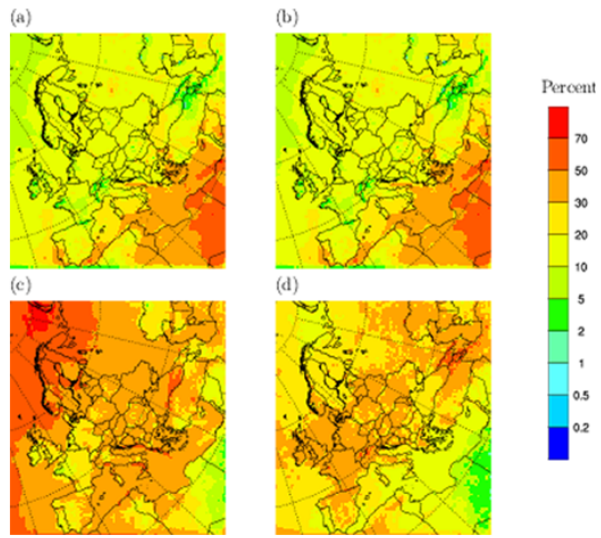
Fig. 11. Calculated percentage contributions to total nitrogen depo- sition for the year 2009: (a) dry deposition of oxidised N r ; (b) dry deposition of reduced N r ; (c) wet deposition of oxidised N r ; (d) wet deposition of reduced N r . Calculations with EMEP MSC-W model (Simpson et al.,